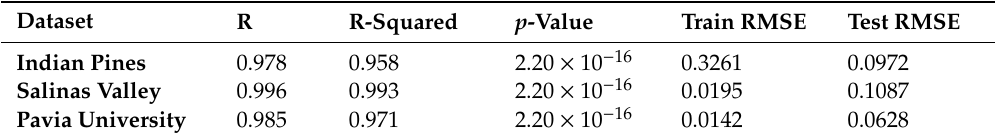
Table 2. The prediction of rules’ hit ratio based on the corresponding entropy values for a 10% training sample